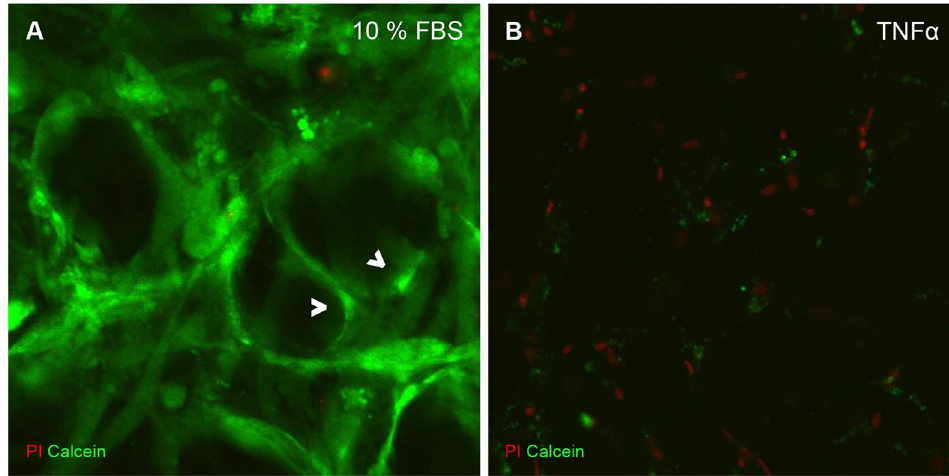
Fig 7. Live imaging of slice cultures on DIV 14. Viability and death of cells were determined via Calcein-AM (cell metabolism, green) and propidium iodide (apoptosis/necrosis, red). A– 14 th DIV, 10% FBS. B– 14 th DIV, TNF α . Calcein positive cytoplasm of adipocytes exemplarily marked with